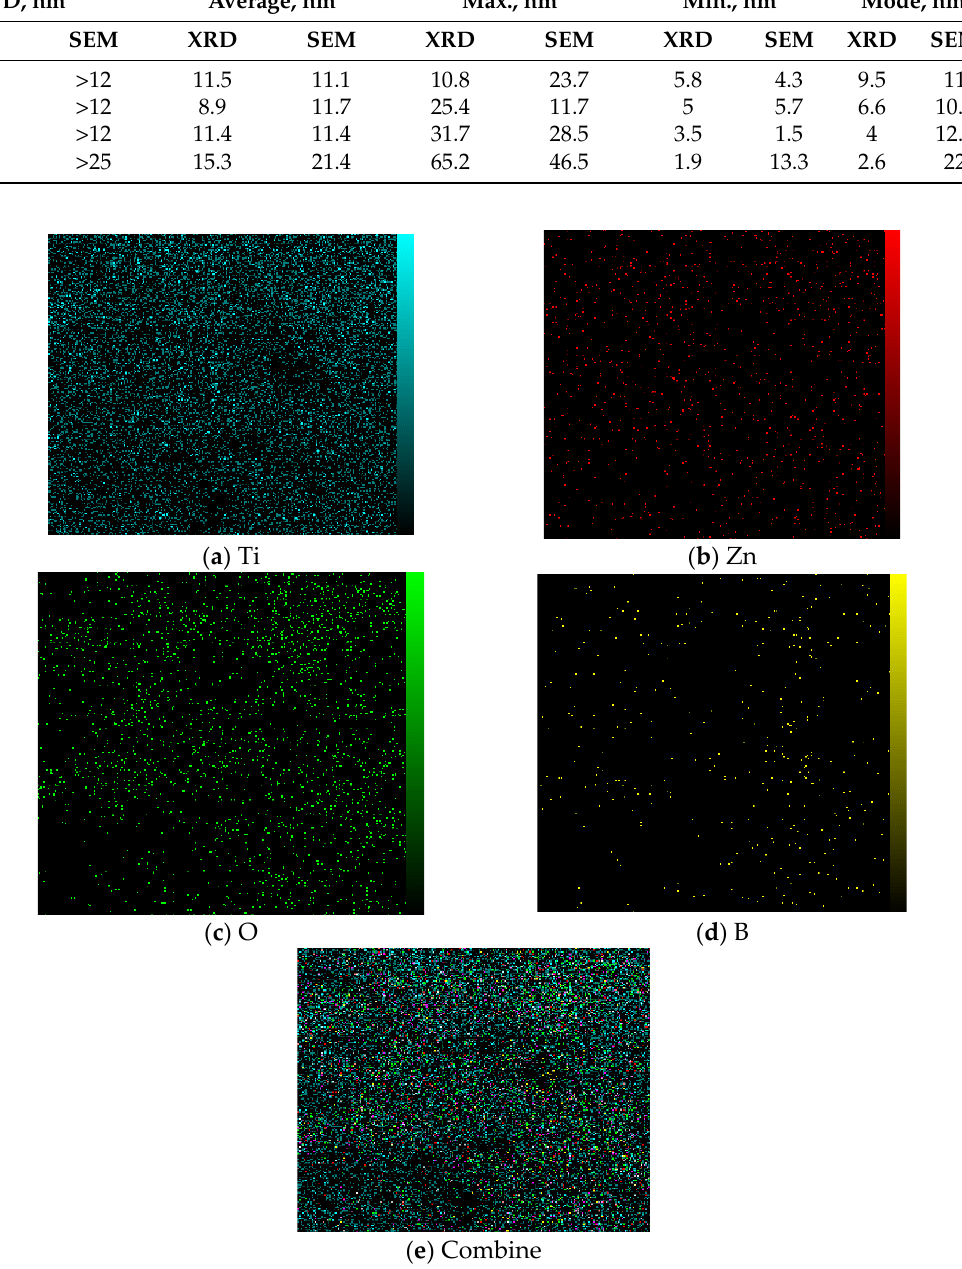
Figure 4. EDS elemental mapping analysis of B-ZnO/TiO 2 nanocomposite.